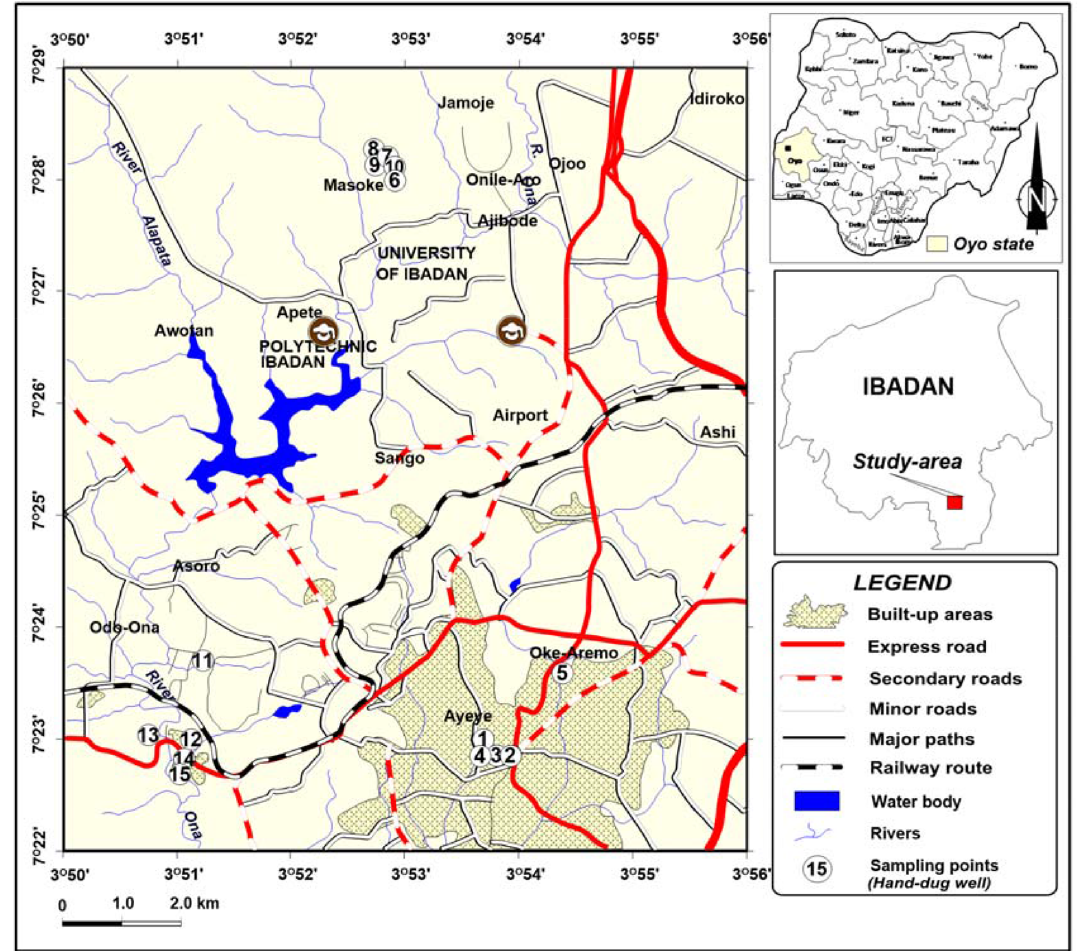
Fig. 2 Location map showing the access roads and water sampling points ( adapted from Google Earth Imagery